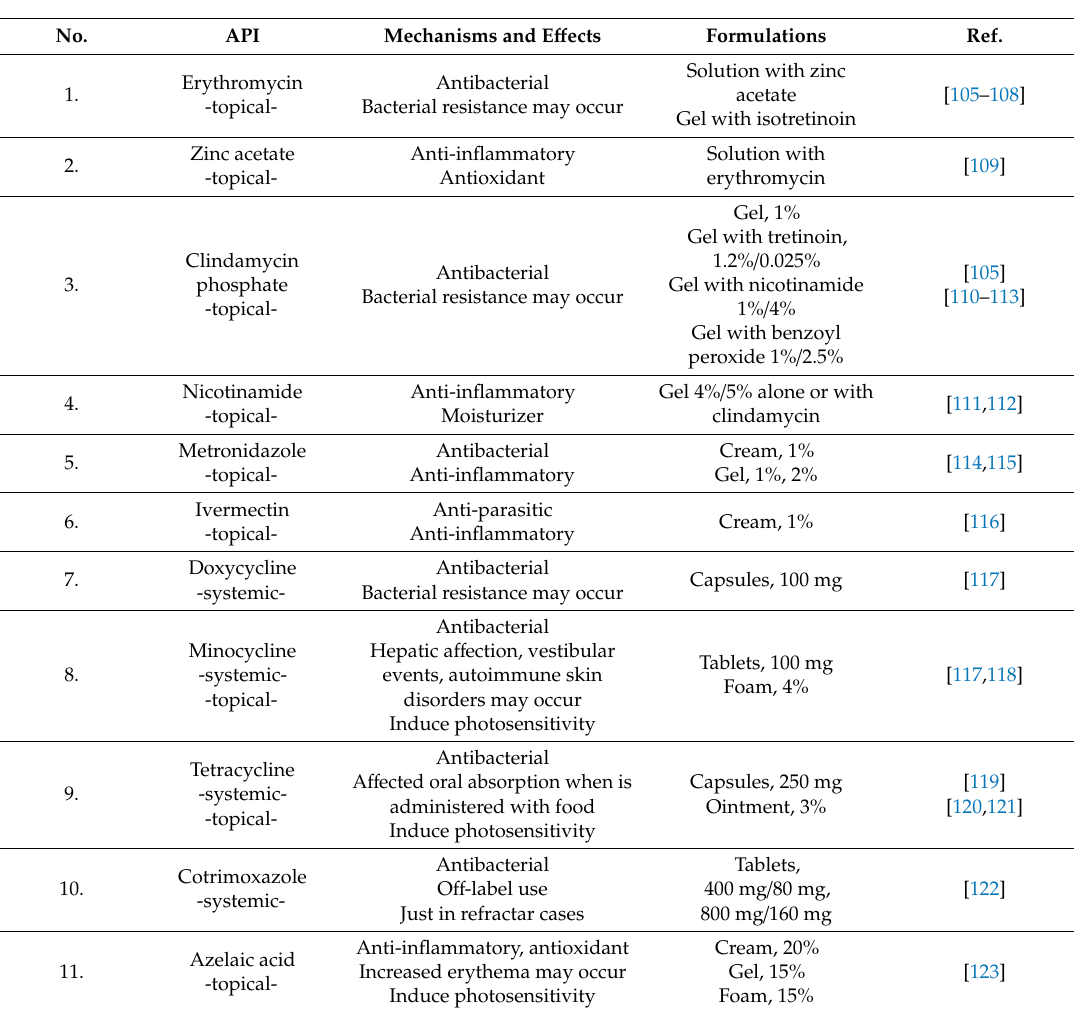
Table 1. Active pharmaceutical ingredients (APIs) mostly used in acne therapy with specific mechanisms and e ff ects and current pharmaceutical formulations used in dermatologic algorithms.